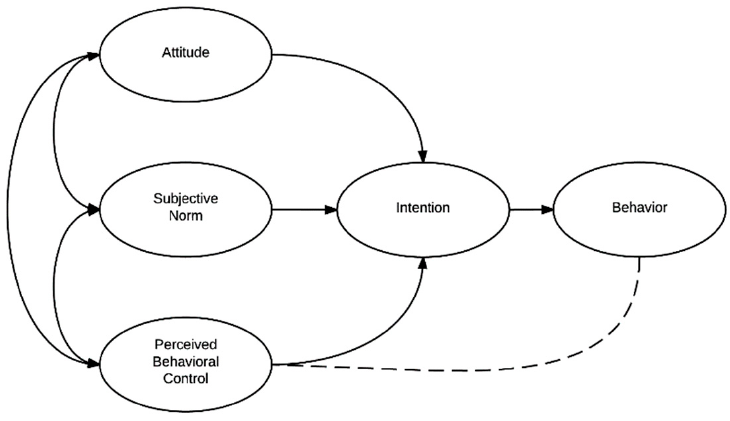
Figure 1. Conceptual model of the theory of rational behavior. Source: (Ajzen, 1991) [21].